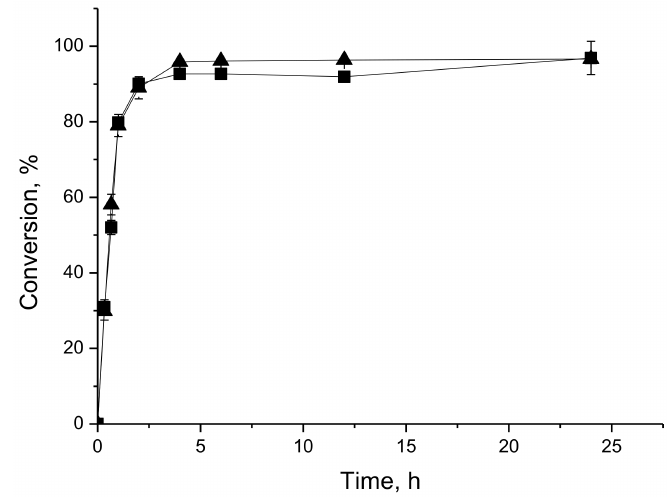
Figure 3. Time-conversion profiles of synthesis of butyl butyrate at 37 ◦ C catalyzed by IMMCALB-T2-350, using 0.1 M in heptane for acids and alcohols, 200 U/g of acid (esterification activity) and 20 g/L molecular sieves. The conversions were assessed by consumption of 1-butanol by gas chromatography (squares) and butyric acid by titration